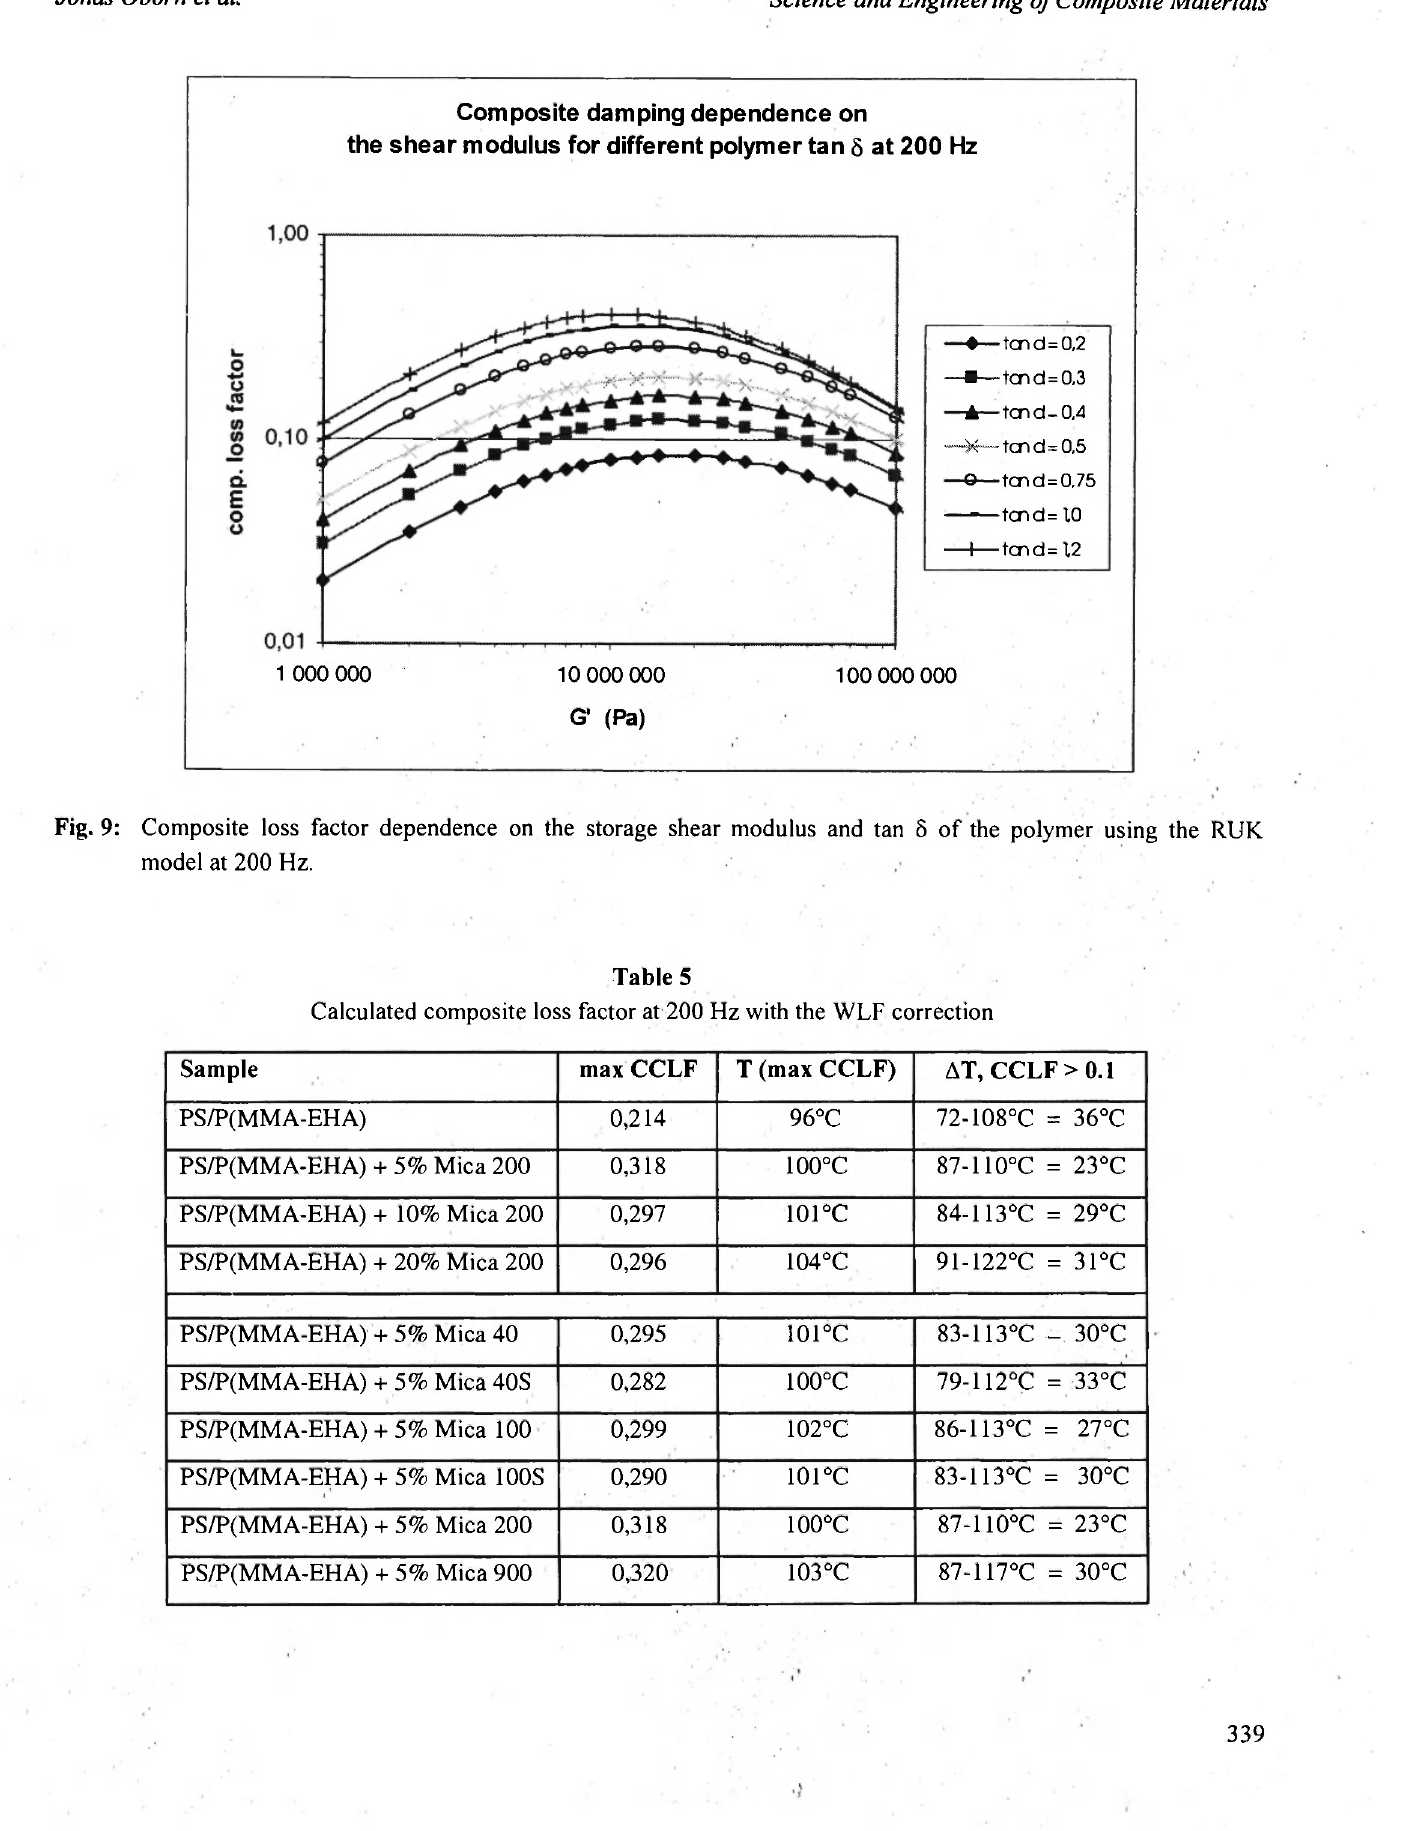
Fig. 9: Composite loss factor dependence on the storage shear modulus and tan δ of the polymer using the RUK model at 200